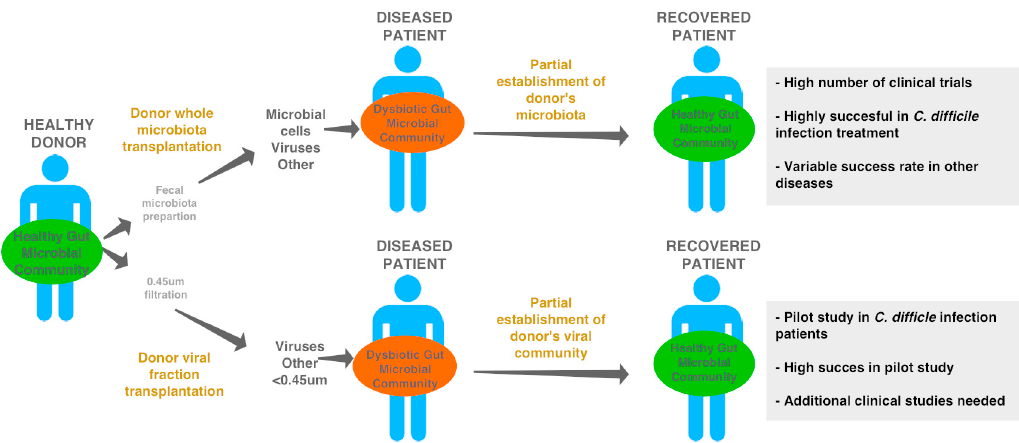
Figure 6. Fecal microbial and the potential of viral filtrate transplant treatment to restore health. Fecal microbial transplants are considered a successful tool to treat certain microbiota-associated diseases and disorders [115–127]. Recently, a pilot study demonstrated that a transplantation of viral filtrates was sufficient to restore health in Clostridium difficile patients. This result highlights the potential for viruses to influence microbial communities, ultimately affecting health and disease.